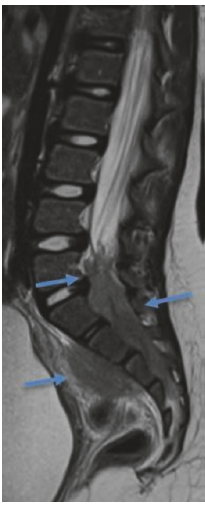
Figure 1: Sagittal T2-weighted MRI of the lumbosacral spine shows a large intracanalar epidural hypointense mass at L5 to S4, extending into the presacral space (blue arrows).